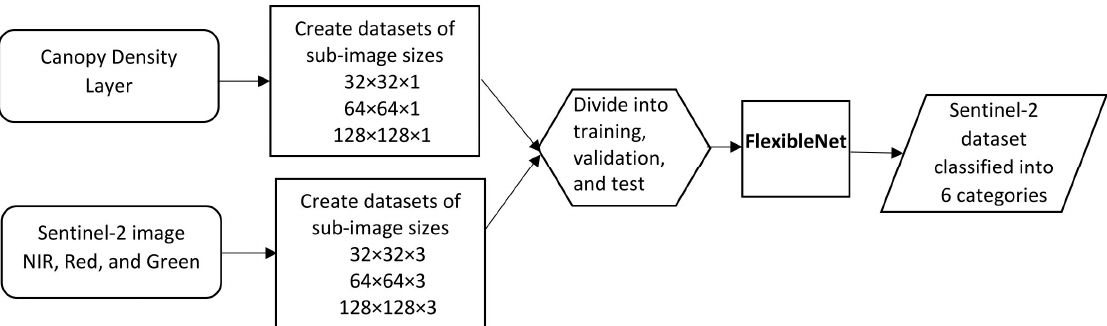
Figure 4. The general process for qualitatively assessing forests’ AGB carbon sequestration capaci- ties .